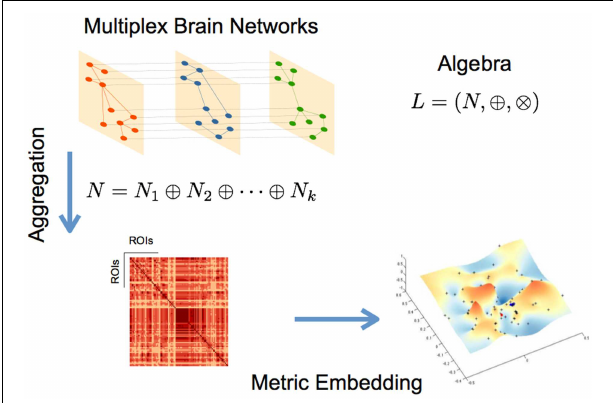
FIGURE 1 | Schematic representation of the main steps for the described networks aggregation and metric embedding (defined here for the algebra L